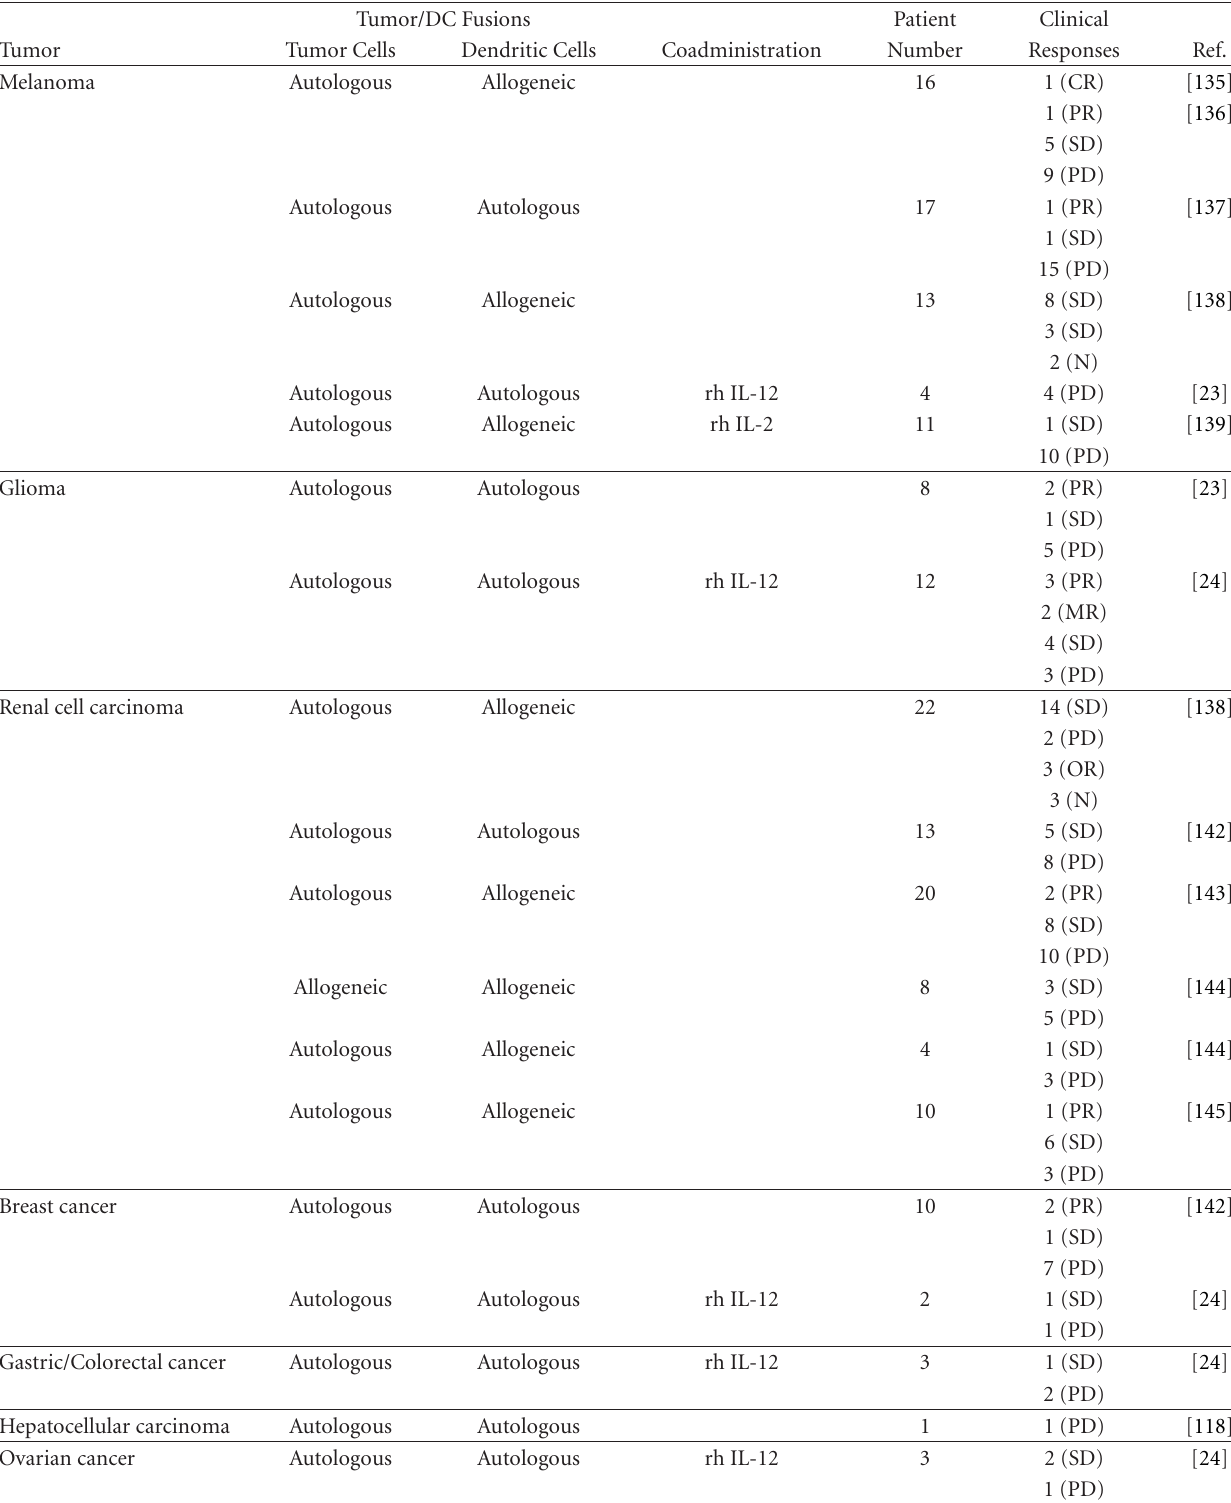
Table 1: Asessment of clinical trials by tumor/DC fusions-based